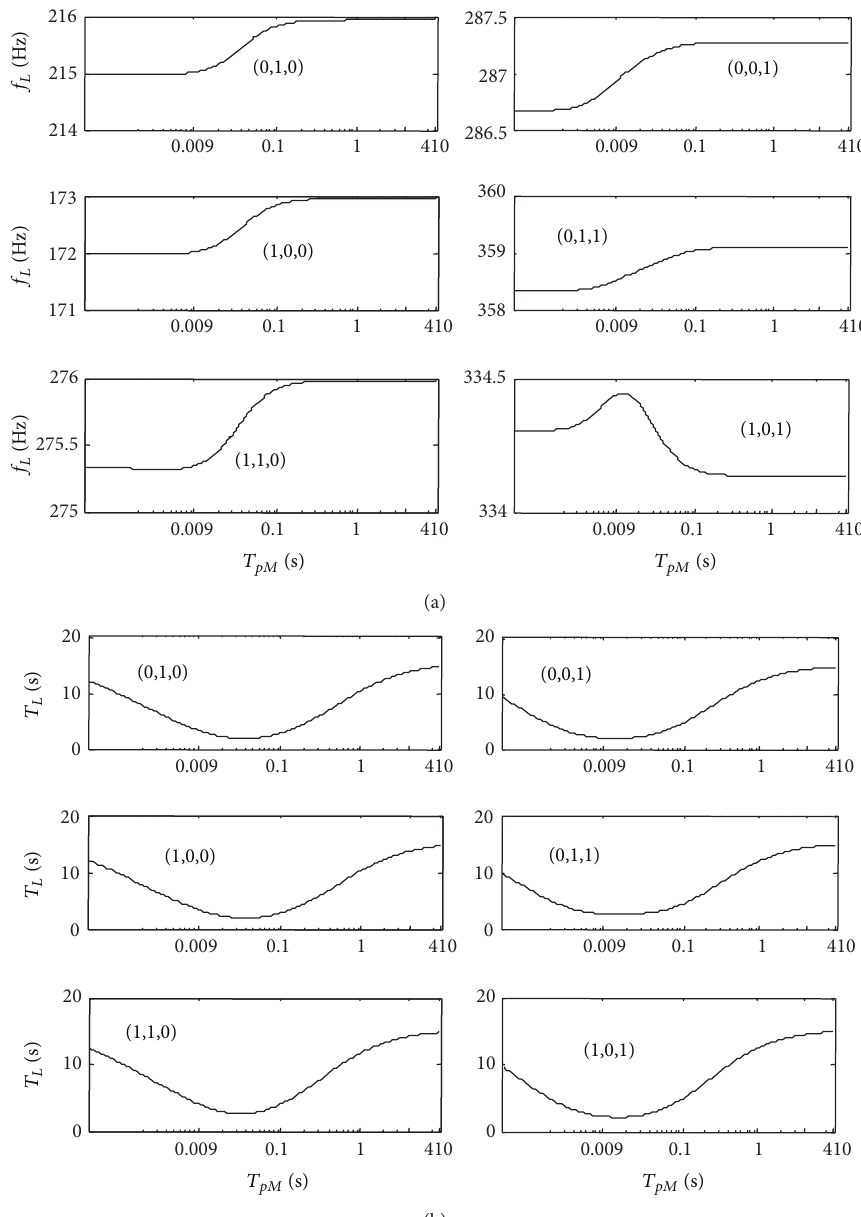
Figure 7: Resonance frequencies and decay times of the first few enclosure-controlled modes as a function of panel modal decay time: (a) resonance frequency, (b) decay time. ℎ = 0.007 m, 𝐿 𝑍 = 0.6 m, 𝑇 𝑎𝑁 = 15